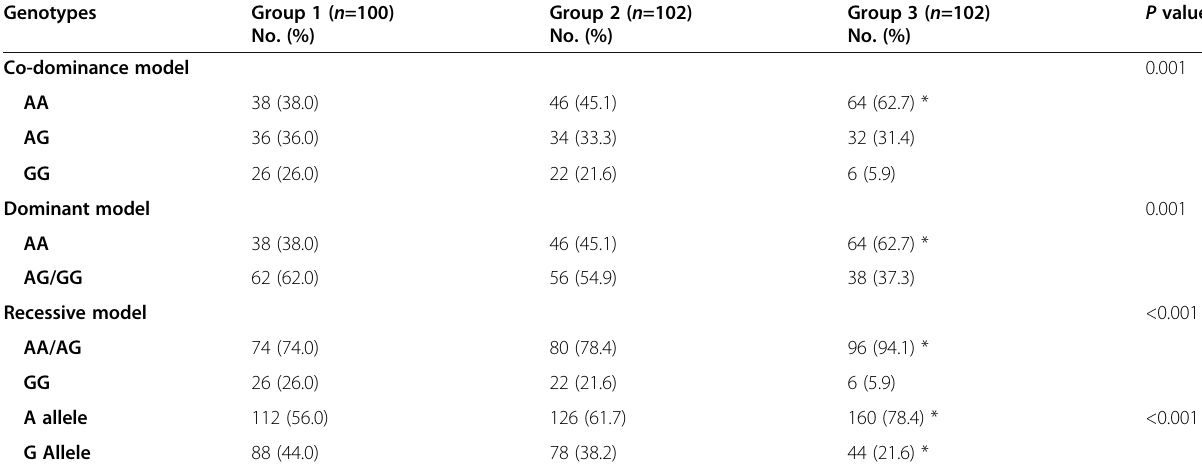
Table 3 ELMO1 rs741301 allele and genotype distribution in studied groups Genotypes